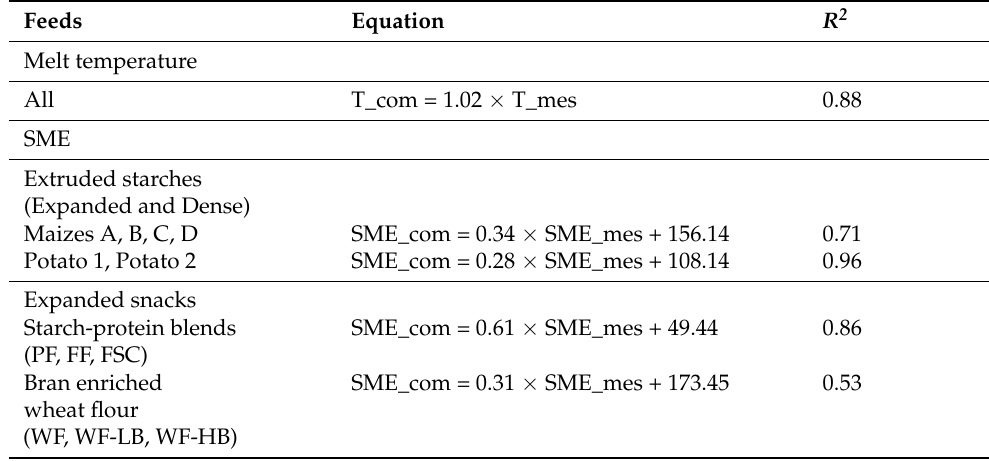
Table A2. Relationship between computed and predicted extrusion variables (Figure